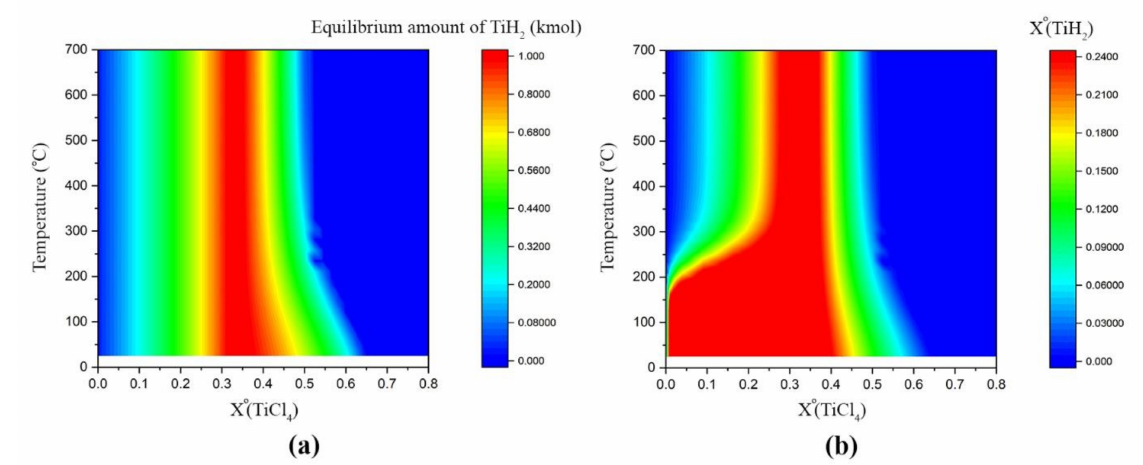
Figure 5. Effect of X ◦ in TiCl 4 -MgH 2 reaction system on ( a ) equilibrium amount of TiH 2 and ( b ) equilibrium TiH 2 TiCl 4 mole